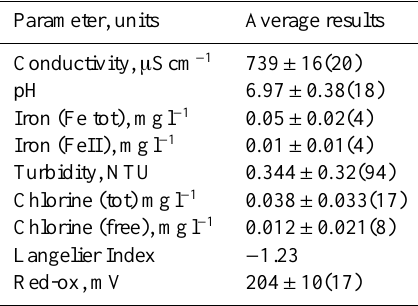
Figure 1. The diagram of the drinking water network indicating numerated circles for locations of resuspension potential method. Flushing sections are indicated with a dashed line. CI pipes are shown in blue, the PVC pipes are shown in orange and the PE pipes are shown in green.